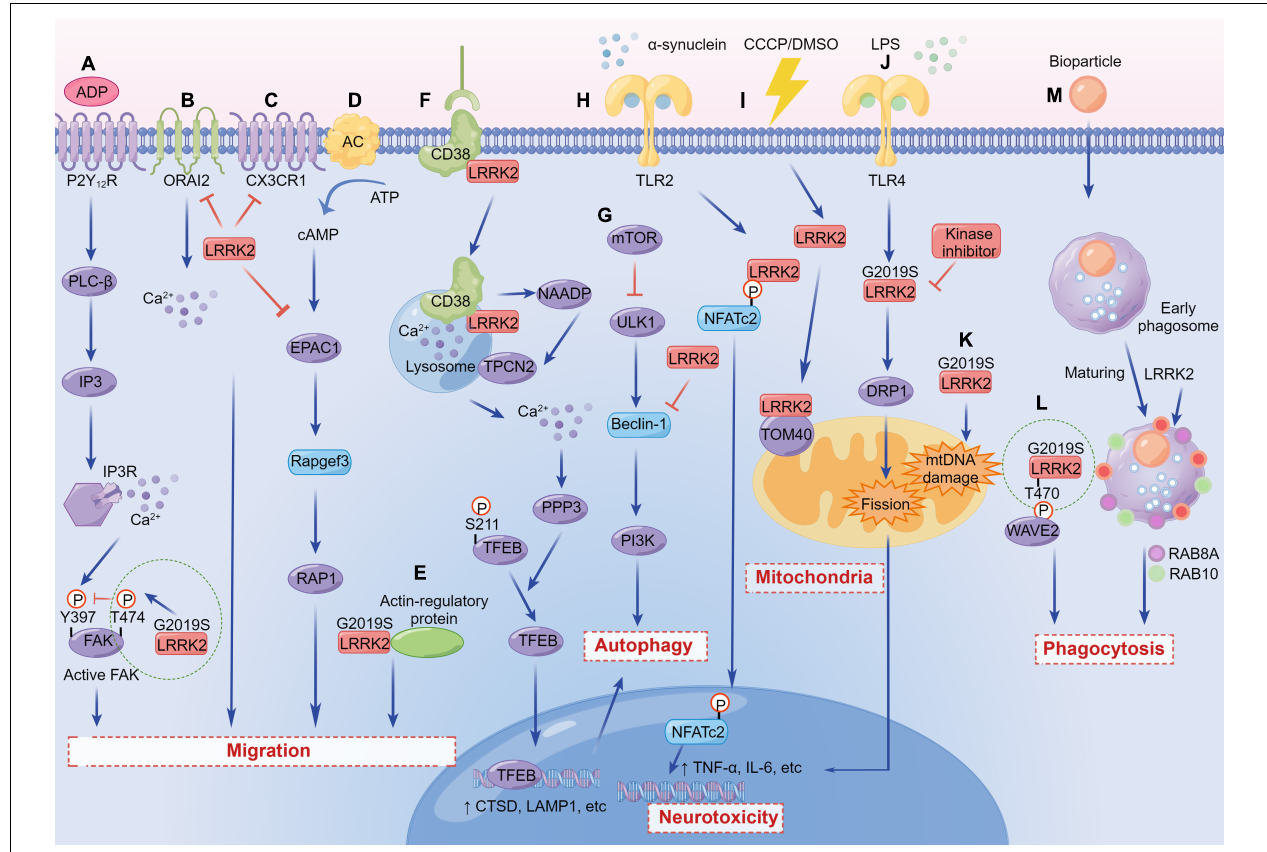
FIGURE 3 | The versatile functions of LRRK2 in immune cells. (A) LRRK2 G 2019 S regulates microglial motility through inhibition of FAK. (B) LRRK2 suppresses the migration of microglia and enhances microglial inflammation by inhibiting the activity of CX3CR1. (C) LRRK2 modulates dendritic cells migration by interfering with ORAI2. (D) LRRK2 suppresses EPAC-1 activity, further restricting motility in macrophages. (E) LRRK2 G 2019 S enhances chemotaxis through enhanced interaction with actin-regulatory proteins in myeloid cells. (F) LRRK2 regulates autophagy by mediating the physiological CD38-LRRK2-TFEB signaling axis in B-lymphocytes and macrophages. (G) LRRK2 inhibits Beclin-1-induced macroautophagy independently of mammalian target of rapamycin (mTOR) and Unc-51-like kinase 1 (ULK1). (H) LRRK2 promotes a neuroinflammatory cascade by selectively phosphorylating and inducing nuclear translocation of the NFATc2. (I) WT and LRRK2 G 2019 S associate and co-localize with subunits of the TOM complex, either under DMSO or carbonyl cyanide m-chlorophenyl hydrazine (CCCP) conditions. (J) LRRK2 promotes microglial mitochondrial alteration via DRP1 in a kinase-dependent manner, initiating pro-inflammatory responses. (K) LRRK2 G 2019 S causes a significant increase in mtDNA damage in PD patient-derived immune cells. (L) LRRK2 G 2019 S binds and phosphorylates WAVE2 at Thr470, stabilizes and prevents its proteasomal degradation, and increases WAVE2-mediated phagocytosis. (M) LRRK2 is required for RAB8A and RAB10 recruitment to phagosomes in